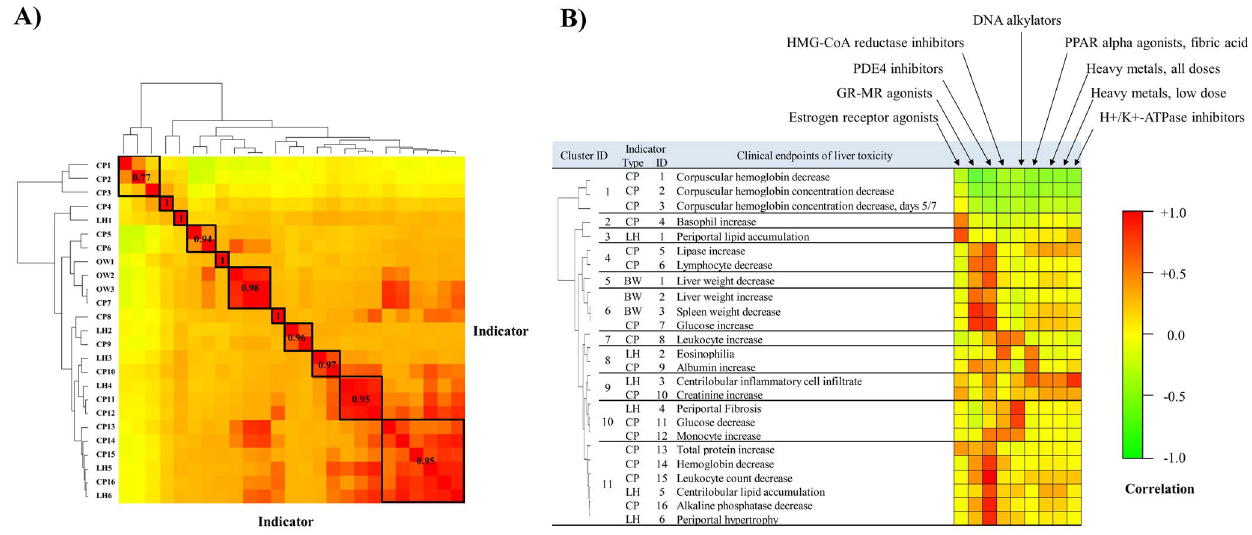
Figure 3. Clustering and analysis of injury indicators using module activation patterns. A ) Correlation among injury indicators. The clinical endpoints used in Table 1 are not independent, but highly correlated both from a biological point of view as well as from the gene transcription activation pattern. The hierarchical clustering dendrogram identifies the most related endpoints based on a Pearson correlation of iterative signature algorithm (ISA) module activation patterns. B ) Correlation of injury indicators with structure activity classes. The clustering of the indicators is shown by a dendrogram at left; at center are the various injury indicators; at right is a heat map with elements equal to the Pearson correlation between the injury indicators at center, and the structure activity indicators arrayed across the top right. The Pearson correlation is determined using the covariance of the ISA module activation patterns of the injury indicators and structure activity classes. The Pearson correlation value in the first column of the table is the average intra-cluster correlation between indicators in the same cluster. CP, clinical pathology; LH, liver histopathology; OW, organ weight.